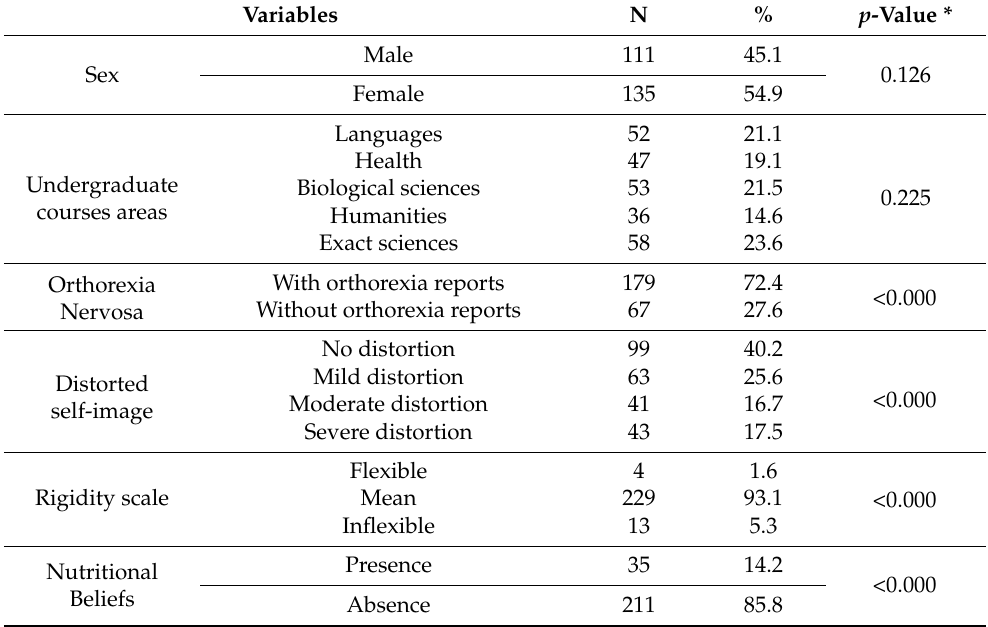
Table 1. Descriptive characterization of the sample of students from a Brazilian Public